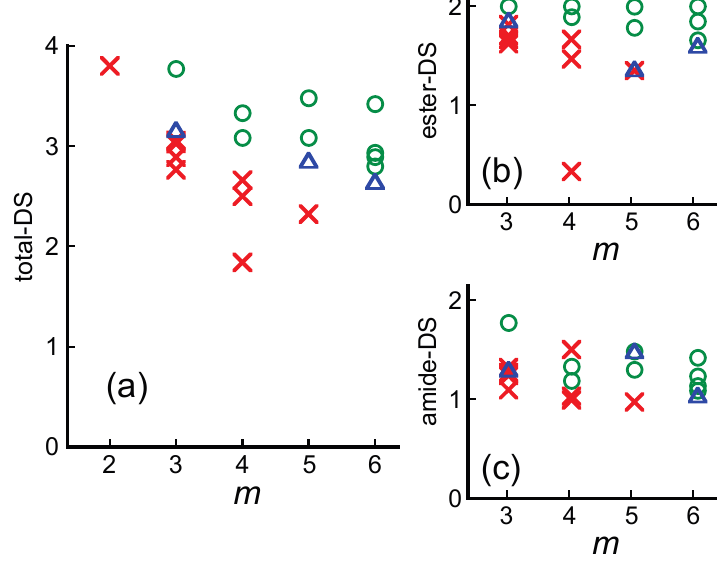
Figure 13. Miscibility maps of different Acyl-Ch/PCL blends as a function of side-chain carbon number m and substitution parameters: ( a ) total-DS; ( b ) ester-DS; and ( c ) amide-DS. Symbols indicate whether a given Acyl-Ch/PCL blend is miscible (circle), immiscible (cross), or partially miscible (triangle). Reproduced with permission from ref. [45]. Copyright